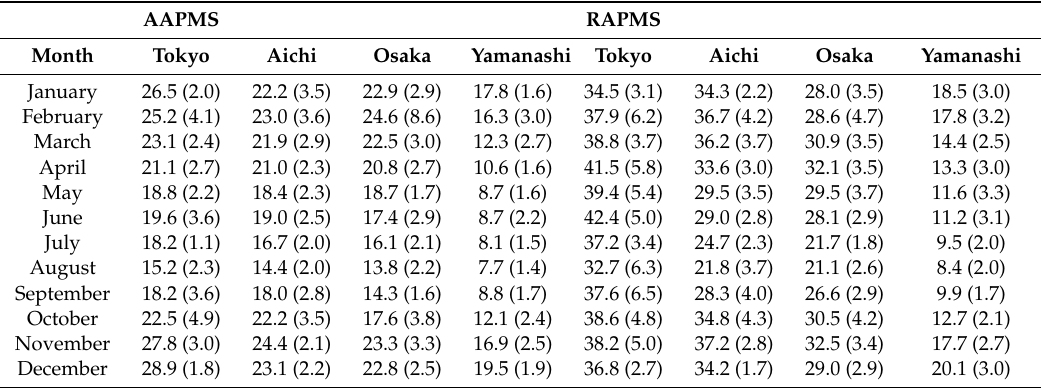
Table 1. Mean (standard deviation) NO 2 concentration (ppb) by month between April 2009 and March